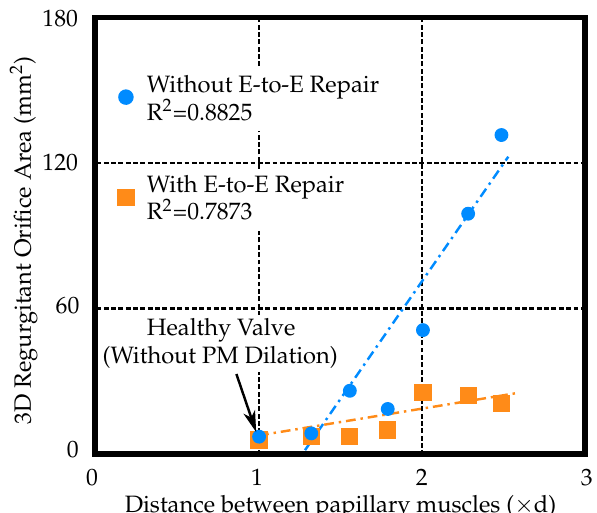
Figure 5. Regurgitant orifice area versus papillary muscles (PM) displacement (where ‘d’ is the distance between papillary muscles of the healthy valve model, i.e., without PM dilation).